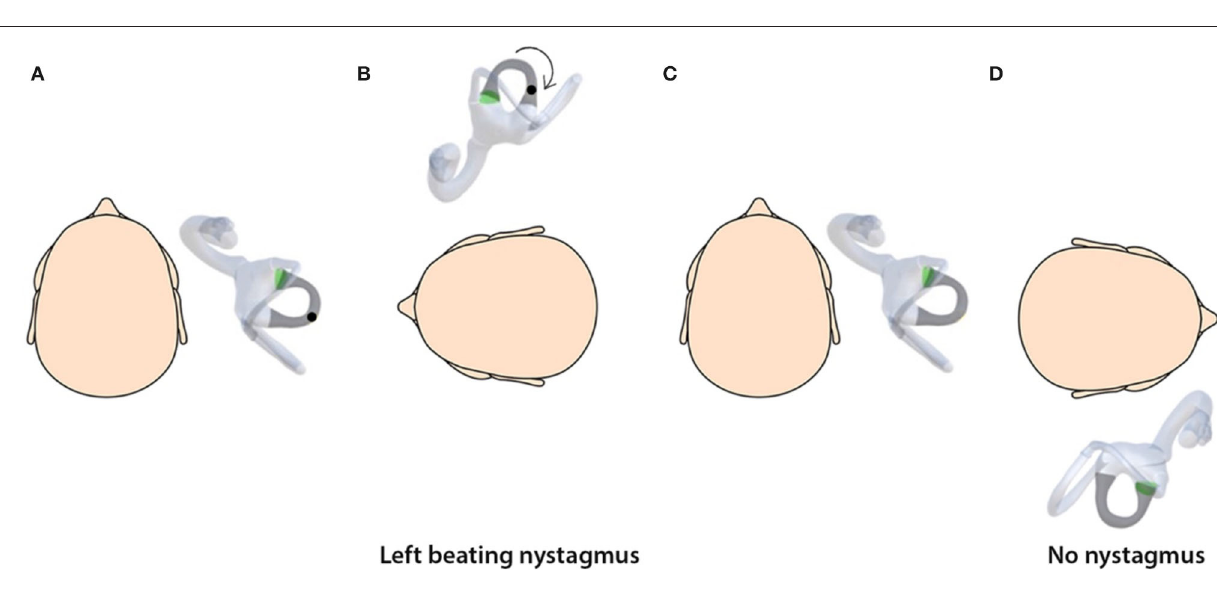
FIGURE 3 | (A) Horizontal canalithiasis with debris in the non-ampullary arm. (B) Starting SRT by turning to the left elicits left-beating nystagmus. (C) The head is turned to the center. (D) Turning the head to the right elicits no nystagmus as the debris has been repositioned out of the canal. Thus, unilateral nystagmus is seen on the unaffected side and no nystagmus on the side